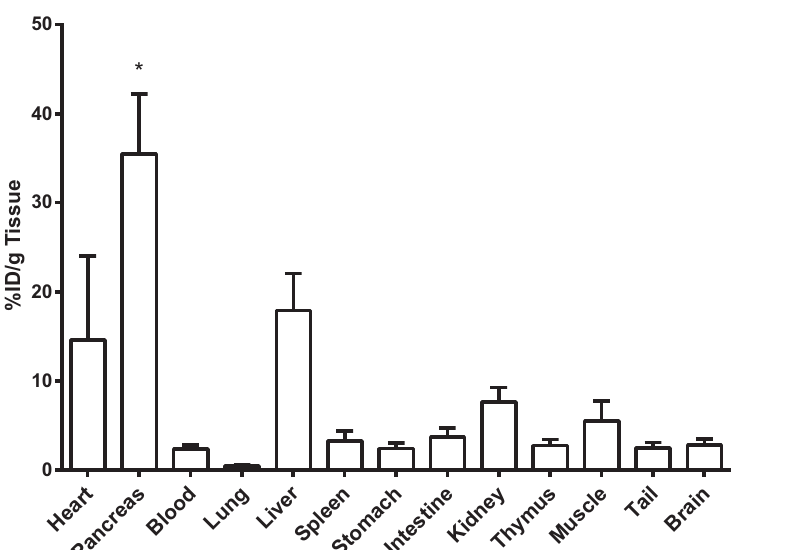
Figure 1. Uptake of 18 F-L-FEHTP in wt mice. Ex vivo biodistribution was calculated for the indicated organs as % injected dose/g tissue (%ID/g tissue) at 1.5 h after injection. Values are given as mean ± SEM (n=6). * p< 0.05 compared to all other organs except heart and liver.